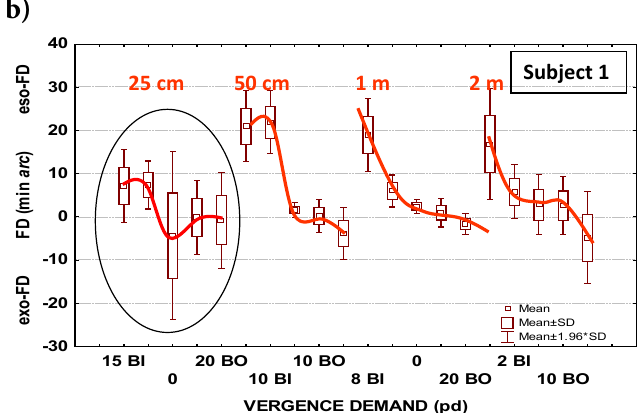
Figure 2. Box and whisker plots for Subject 1 for the different vergence demands and for different stimulus distances are shown. In part a ) only results for one stimulus distance (0.25 m) are included whereas in part b ) these same results and also those for three other stimulus distances are included. Small squares with red curves indicate mean fixation disparities (FD) under specific vergence demands (measured with no prism, or with base in or base out prism.) Larger boxes and whiskers are used to indicate sample variation by means of sample standard deviations. a) Subject 1, 0.25 m, b) Subject 1, 0.25, 0.5, 1 and 2 m.